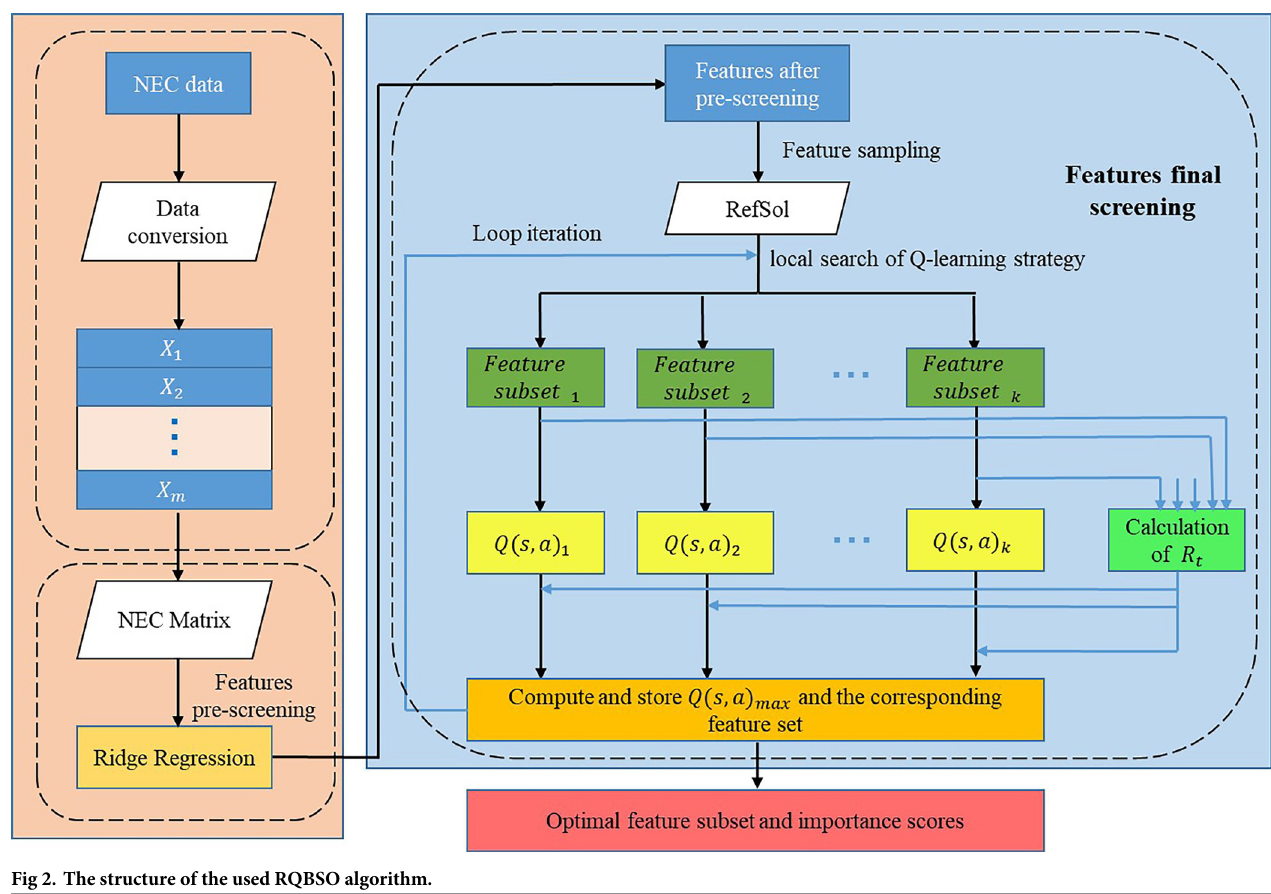
Fig 2. The structure of the used RQBSO